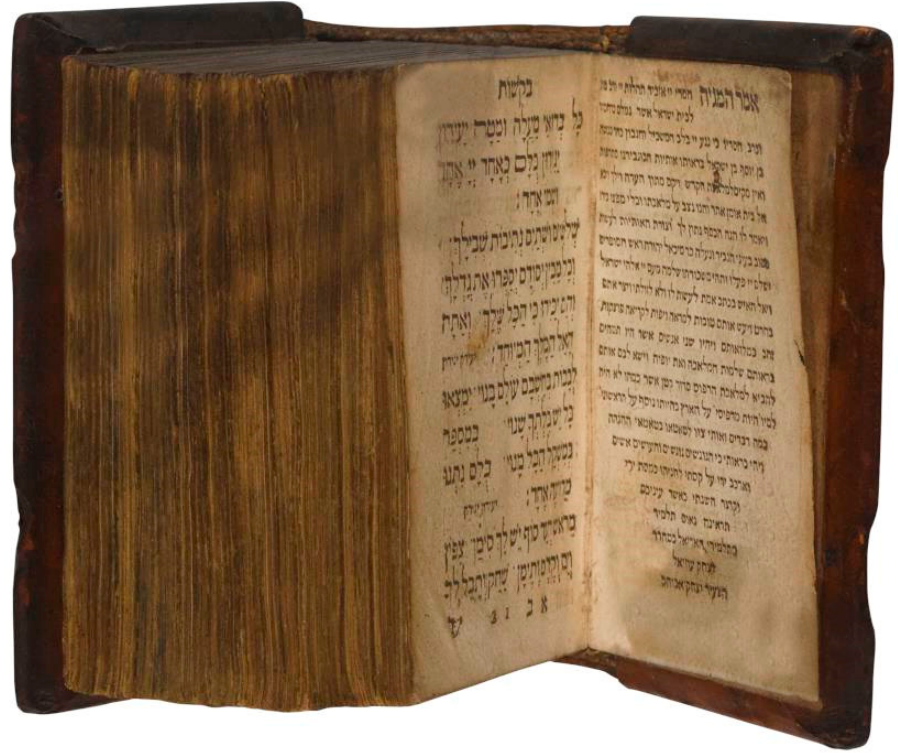
Figure 19. Seder Tefilot, Sephardi Prayer Book; Marsh’s Library B.3.5.47.